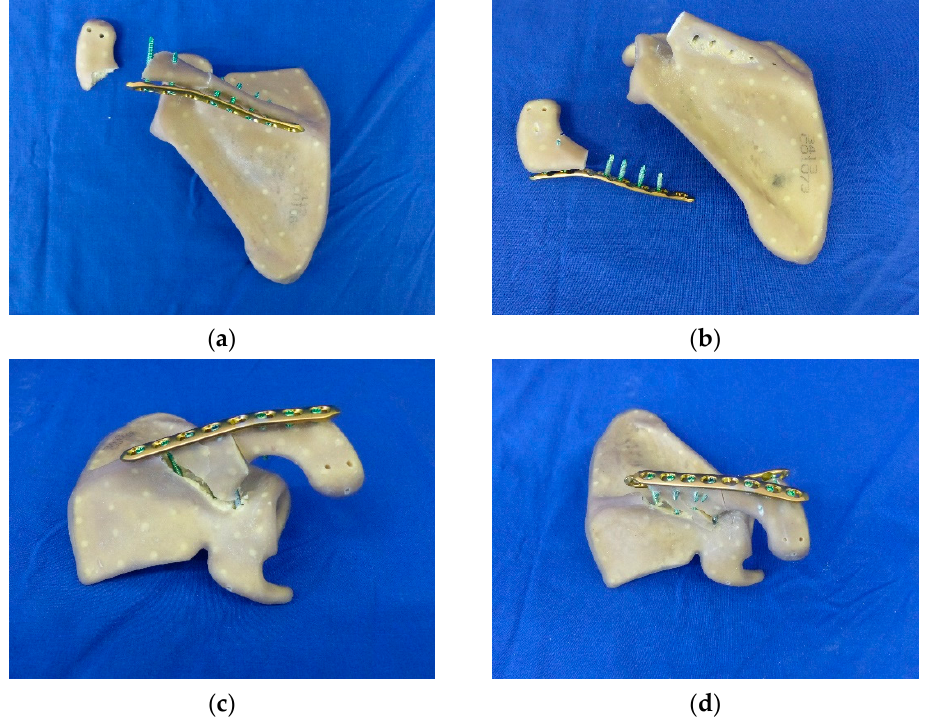
Figure 7. Varying fracture patterns were detected among groups: ( a ) acromion fracture in LCPcaudal, ( b ) failure of medial screws in LCP caudal, ( c ) fracture of spina (LCPdorsal), and ( d ) wedge-shaped fracture from the most medial screw extending to the scapular notch (LCPdouble).